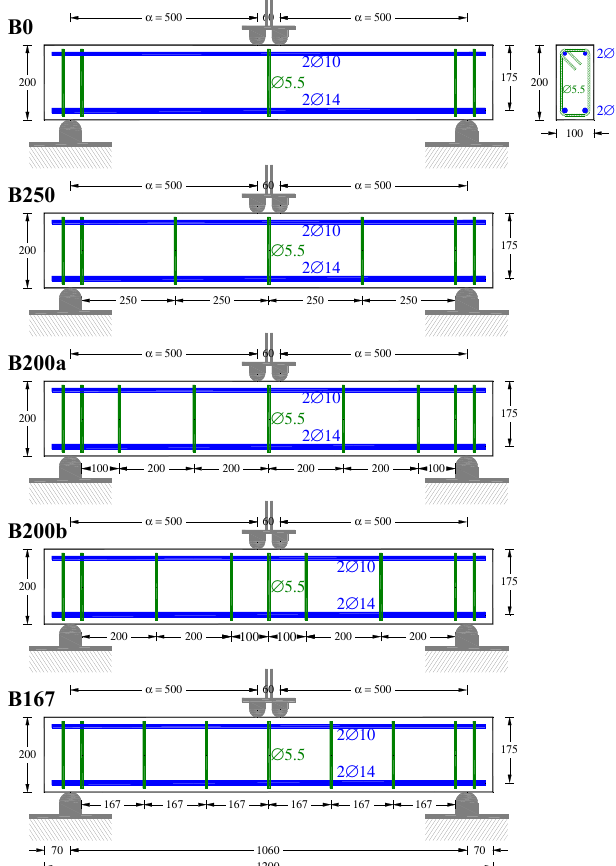
Figure 1. Geometrical characteristics and steel reinforcement arrangement of the initially tested beams (dimensions in mm).